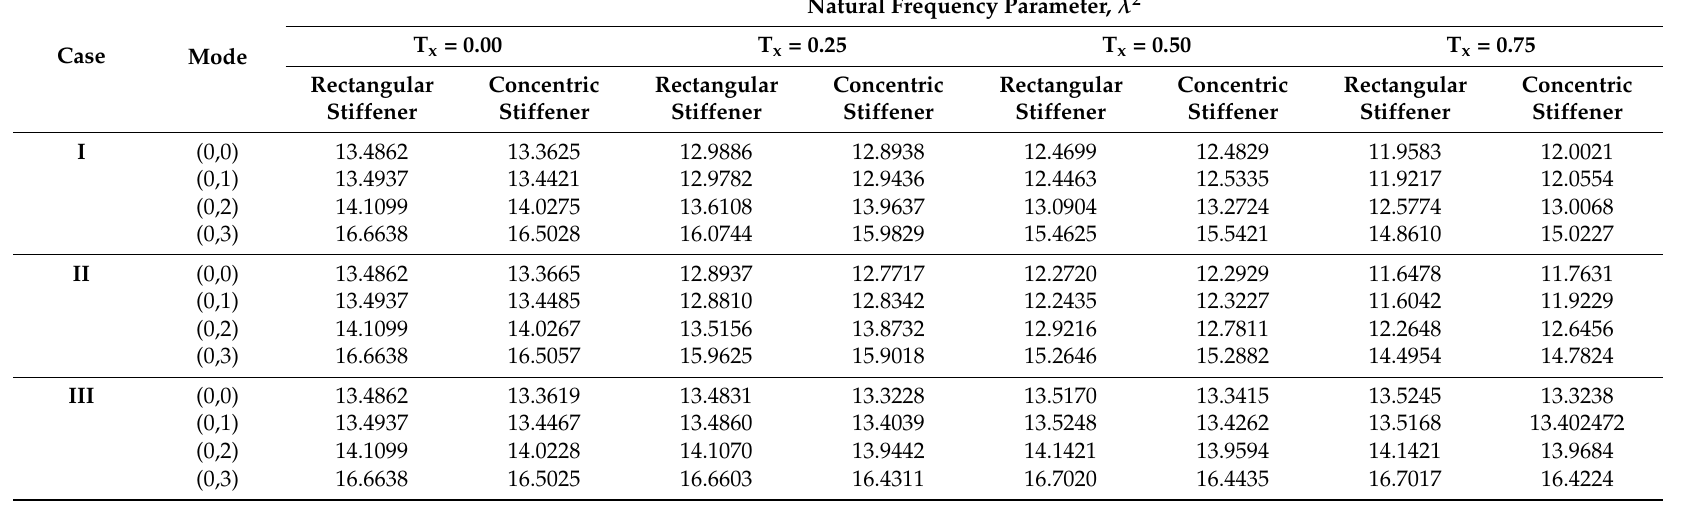
Table 5. Numerical comparison of natural frequency parameter λ 2 of plate with 2 rectangular and 2 concentric stiffener patches for different thickness variations and for different taper ratios T x